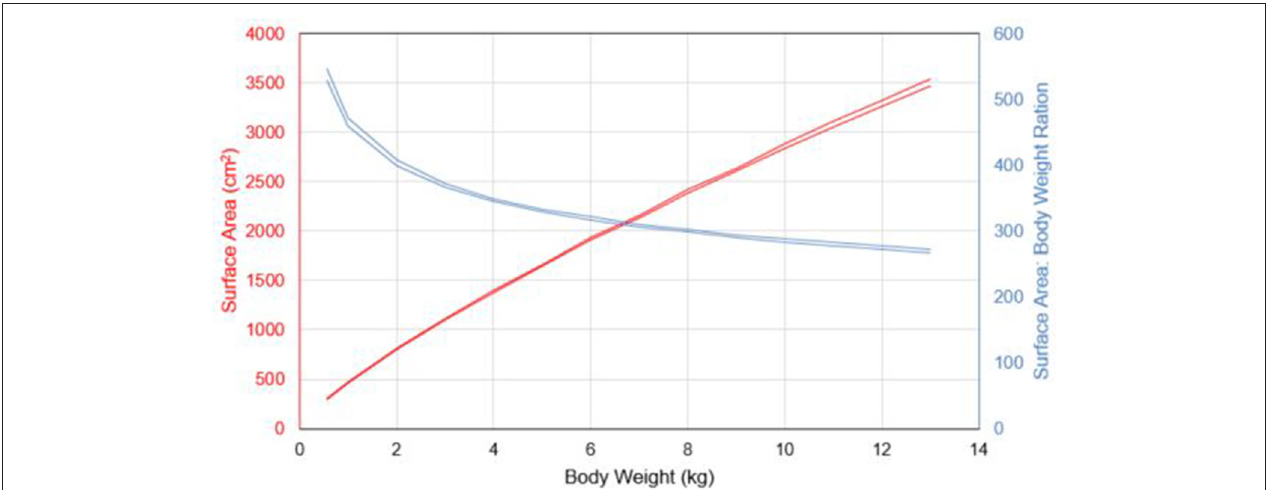
FIGURE 3 | Sensitivity analysis (upper and lower 95% CI) of the dimensions used to calculate surface area of a piglet. Surface area (red lines) and the surface area: body weight ratio (blue